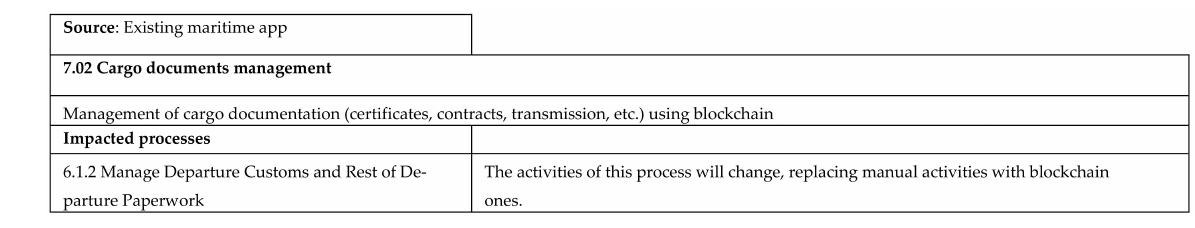
Figure A43. Cont